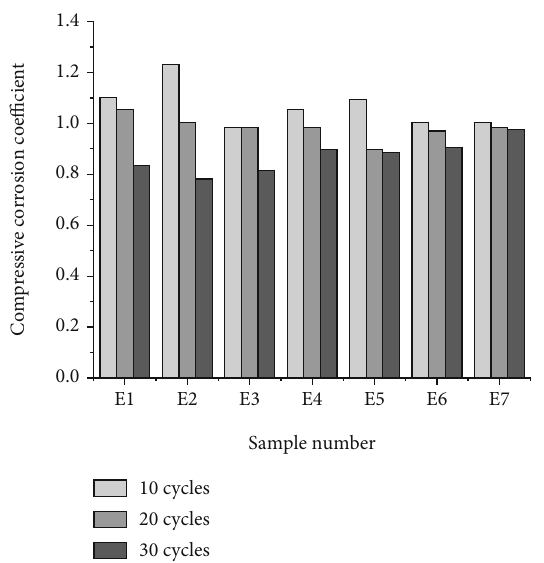
Figure 3: Accelerated sulfate corrosion 0 cyclic compressive corrosion coe ffi cient of pile foundation concrete.